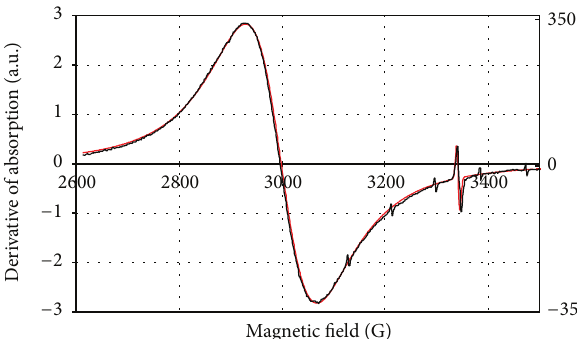
Figure 8: EPR spectrum type III ( > 30 and < 50 mol% CuO).